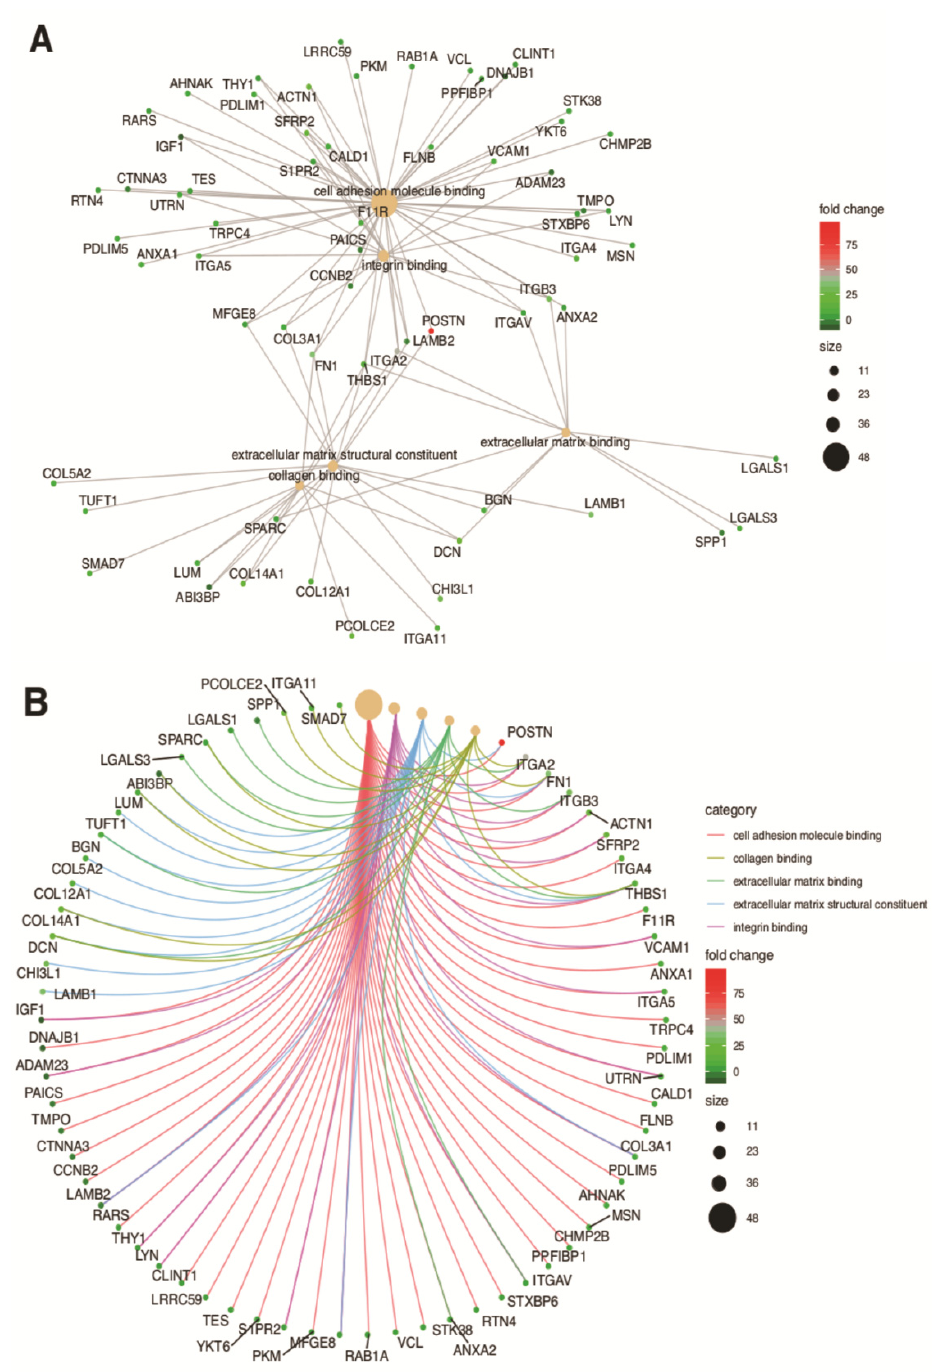
Figure 5. Analysis of enriched gene ontological groups involved in ( A ) cell adhesion molecule binding, collagen binding, extracellular matrix binding, extracellular matrix structural constituent, integrin binding. The network plots presenting the linkages of genes and GO MF terms; ( B ) cadherin and collagen binding and structuralization of extracellular matrix components. The network plots presenting the linkages of genes and GO MF terms.